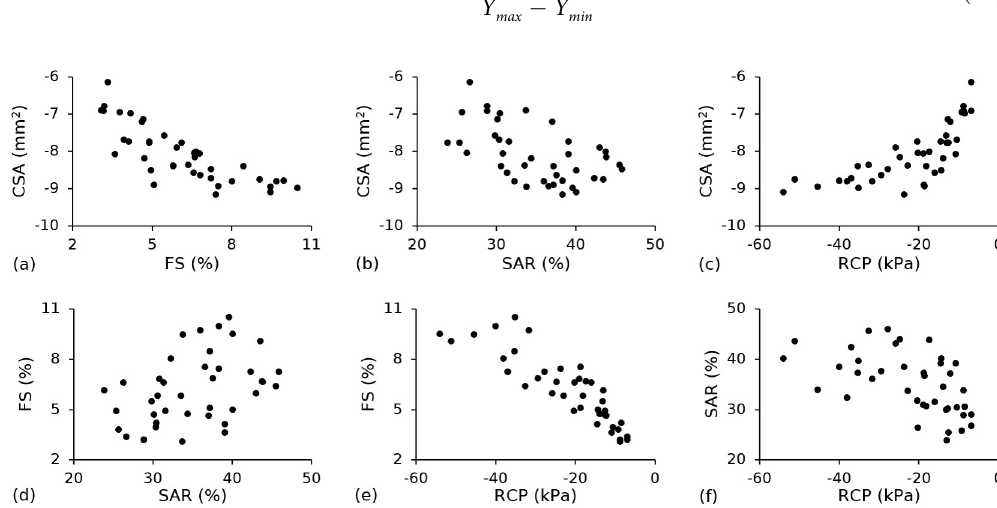
Fig 15. Trade-off curves for all permutations of the four performance metrics: (a) CSA vs . FS ; (b) CSA vs . SAR , (c) CSA vs . RCP and (d) FS vs . SAR , (e) FS vs . RCP and (f) SAR vs . RCP